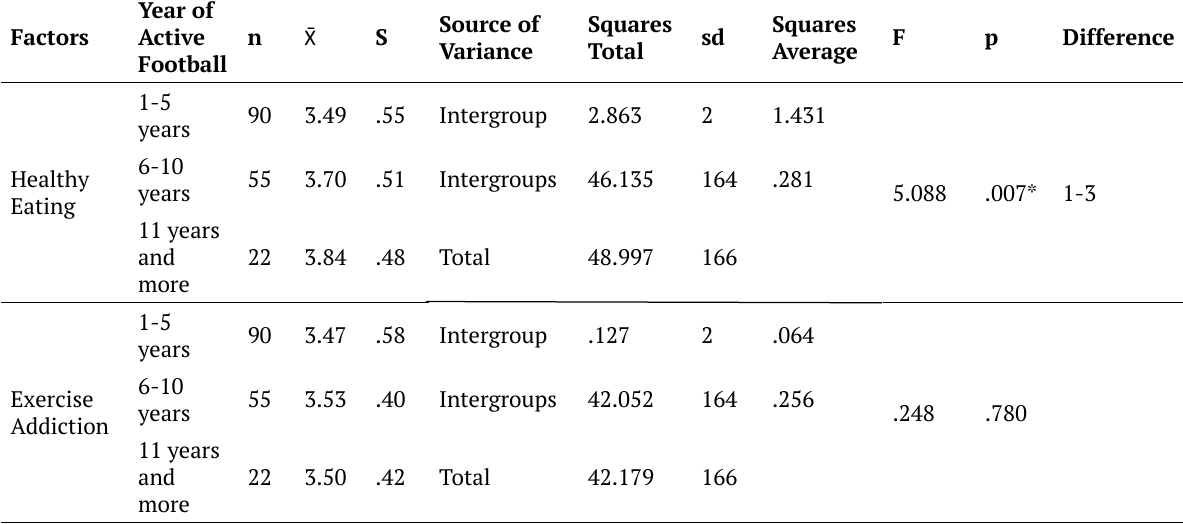
Table 6. ANOVA results of female football players’ attitudes and exercise addiction to healthy eating by